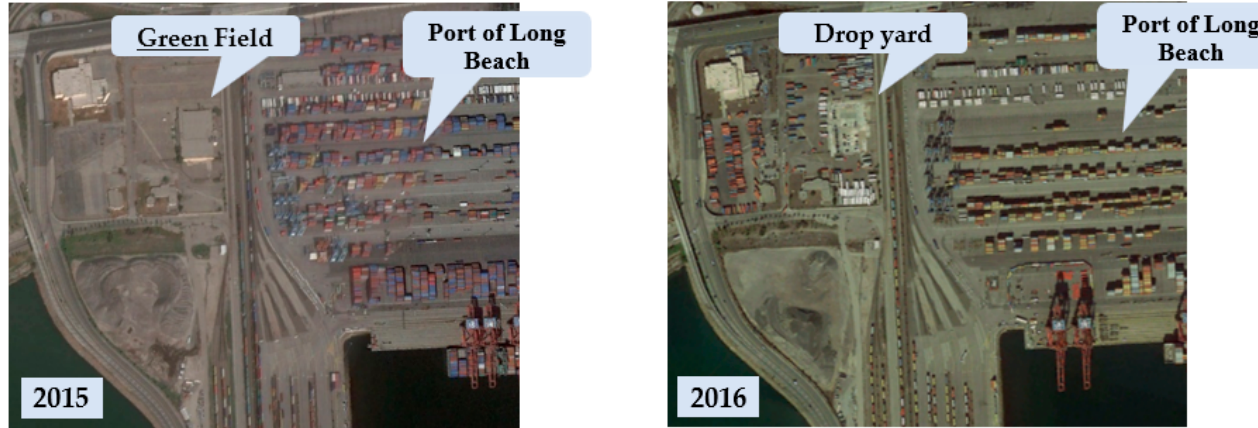
Figure 1. Newly established drop yard at the Port of Long Beach. The truck staging yards at the Ports of Virginia and Tacoma effectively extend the ing queues to expand indefinitely. The loaded container staging yards at the California ports serve a different purpose: increasing terminal fluidity and capacity and improving customer